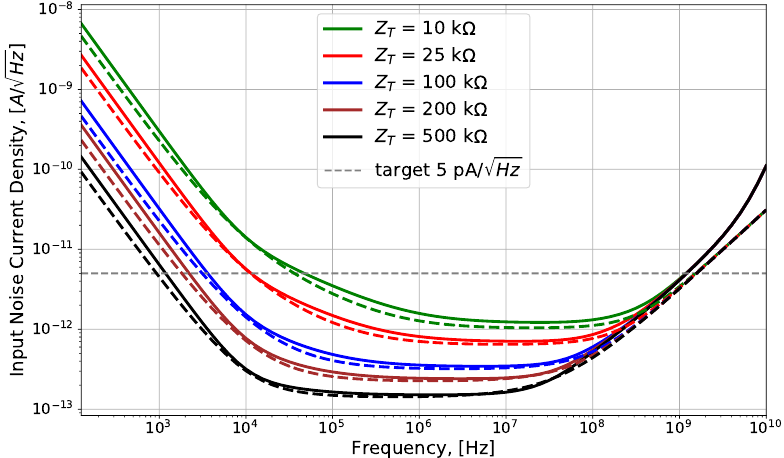
Figure 10. Proposed analytical model for the input-referred noise current density and Cadence- simulated noise for programmable-gain TIA configuration in IHP 0.25 µ m BiCMOS. Solid lines are due to Cadence simulation; dashed lines are due to the developed analytical noise